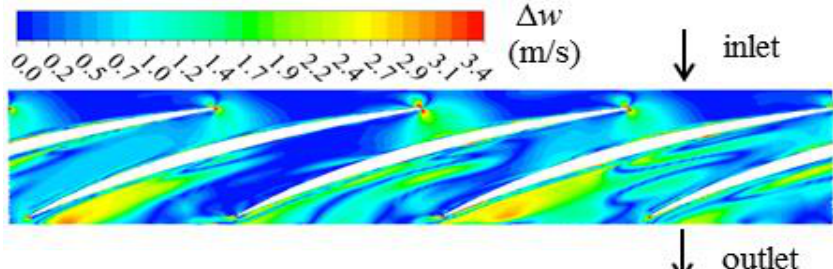
Figure 8. Distribution of velocity difference between the two phases in the impeller at IGVF = 21% (span = 0.5).